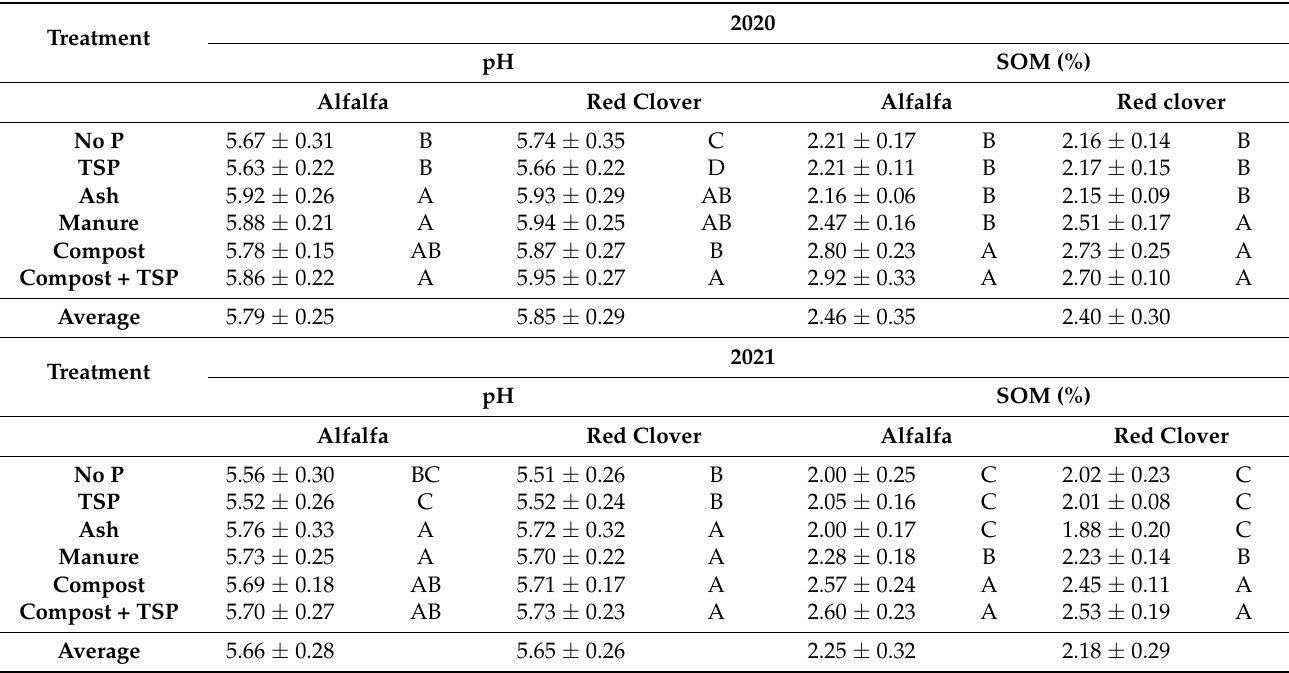
Table 3. Soil organic matter (SOM) and pH (CaCl 2 ) of the soil samples taken after harvest in 2020 and 2021 from the six treatments (no P, TSP, ash, manure, compost, and compost + TSP).